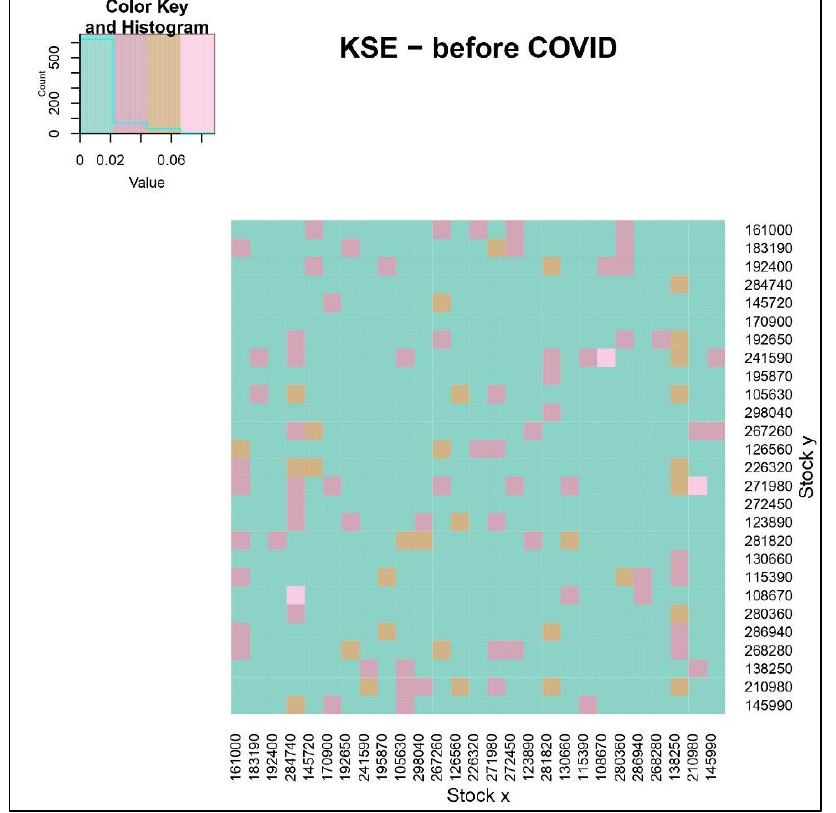
Figure 11. The information flow (effective transfer entropy) from stock y to stock x, for the top companies (by market capitalization) in the KSE market, before the COVID-19 outbreak